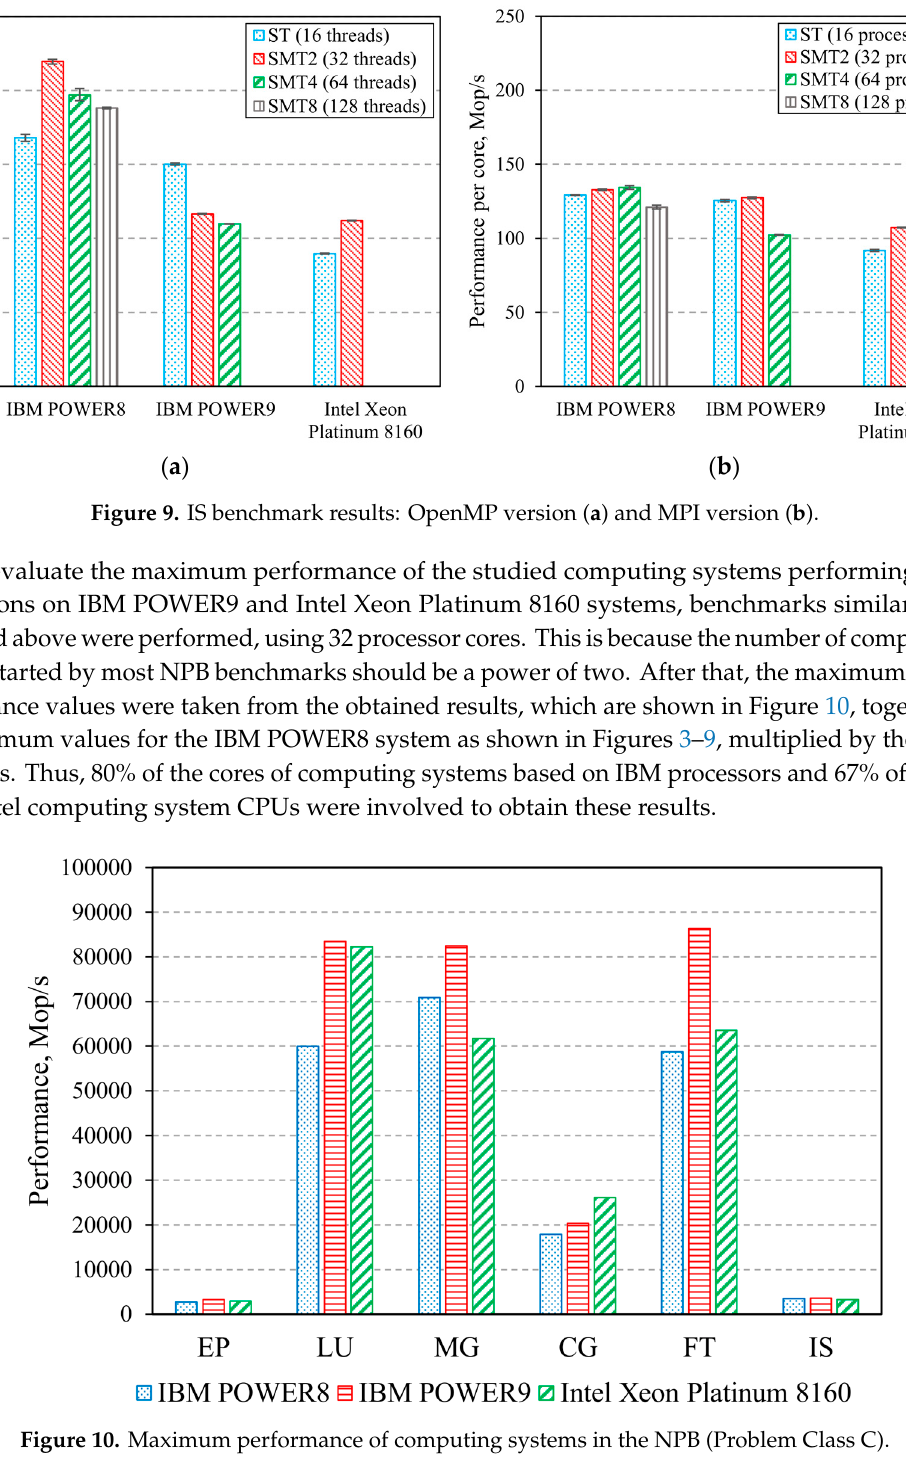
Figure 8. FT benchmark results: OpenMP version ( a ) and MPI version ( b ).